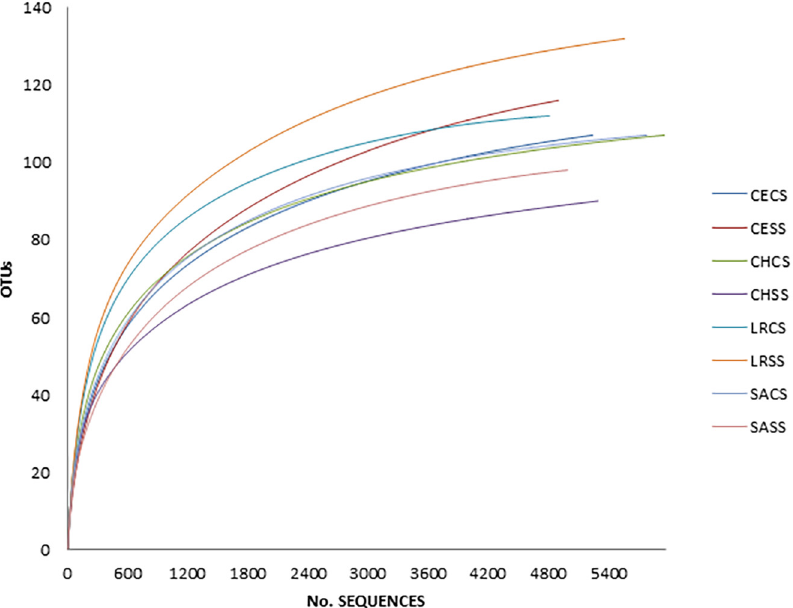
Fig 1. Rarefaction curve at 0.97 similarity of water samples from 4 coastal lagoons: Celestun (CE), Chelem (CH), Laguna Rosada (LR) and Sabancuy (SA); in the two culture conditions: CS (water samples grown tryptone soy broth + 3% NaCl) and SS (water samples cultured in tryptone soy broth).